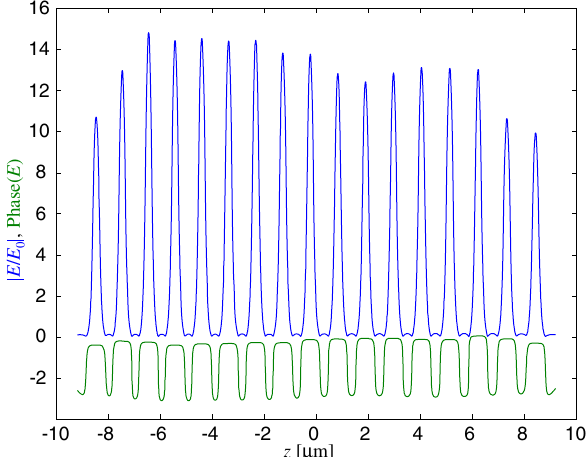
FIG. 4. E component of the field at the center of the enclosed z tapered MLA structure. Blue, magnitude; green,